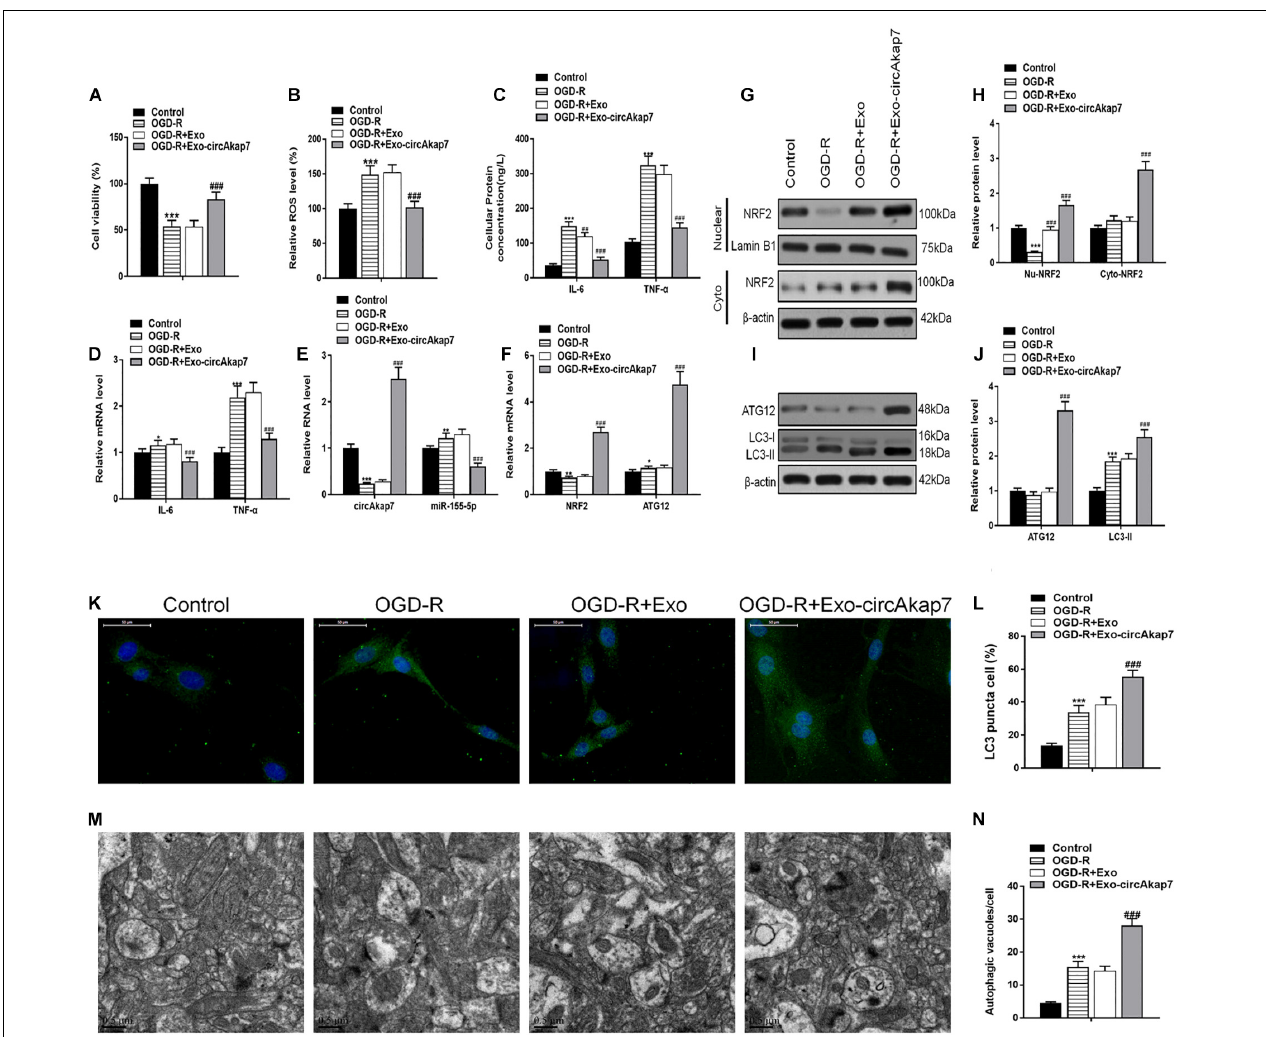
FIGURE 5 | Co-culture with exo-circAkap7 attenuates OGD-R-induced cellular injury in primary astrocytes. (A) Cell viability assessed by an MTT assay. (B) Detection of cellular ROS levels. (C) ELISA results showing the expression of IL-6 and TNF- α in astrocytes. (D) RT-PCR results showing the levels of IL-6 and TNF- α in astrocytes. (E,F) RT-PCR results showing the levels of circAkap7, miR-155-5p, ATG12, and NRF2 in astrocytes. (G,H) The expression of cytosolic and nuclear NRF2 as analyzed by western blot and quantified. (I,J) The expression of ATG12 and LC3B as analyzed by western blot and quantified. (K,L) Representative photomicrographs and quantification of LC3B-positive puncta in cells. Nuclei were counterstained with DAPI (blue). (M,N) Autophagic vacuoles (autophagosomes) as detected by TEM. Representative TEM images are shown, with typical autophagosomes marked with black arrows. The number of autophagosomes per cell was calculated by counting the number of double-membrane organelles in 10 cells. Data are expressed as the mean ± SEM, each experiment was repeated six times. * p < 0.05, ** p < 0.01, *** p < 0.001 vs. control, ## p < 0.01, ### p < 0.001 vs.